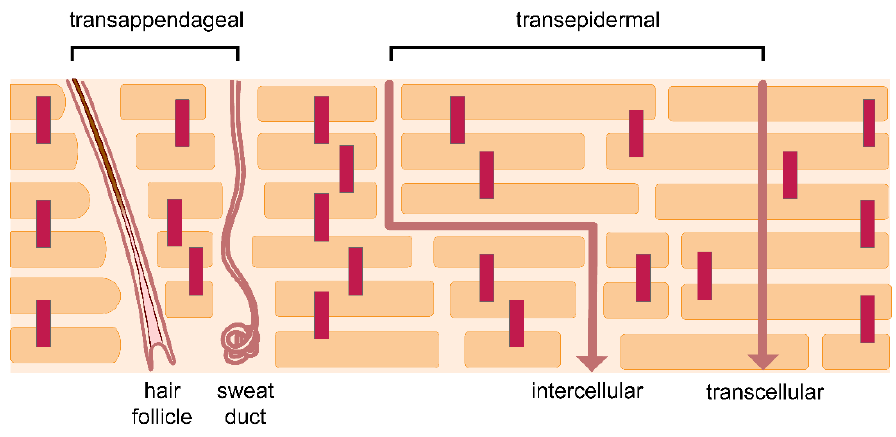
Figure 3. Skin permeation